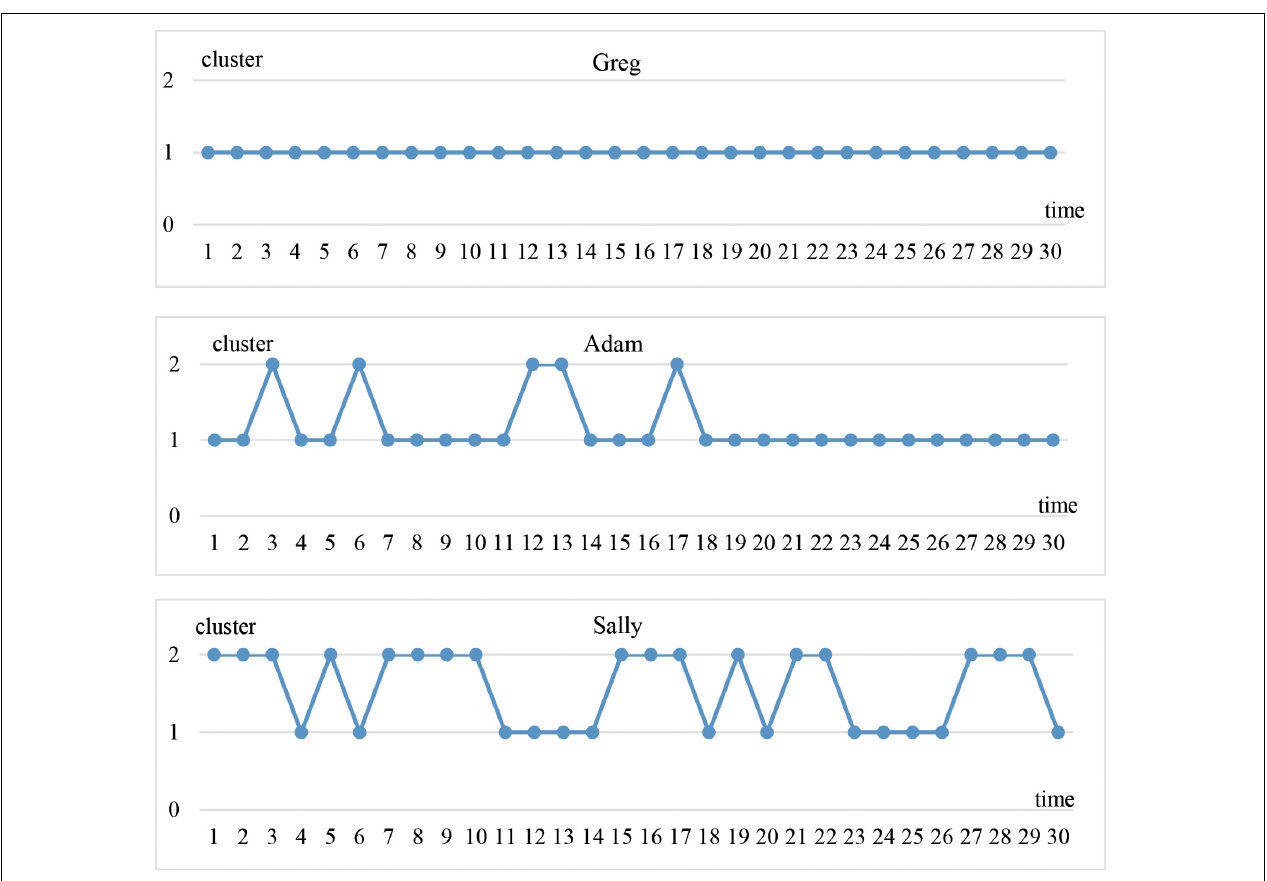
FIGURE 2 | Representative change trajectories between clusters of the three prototypes.